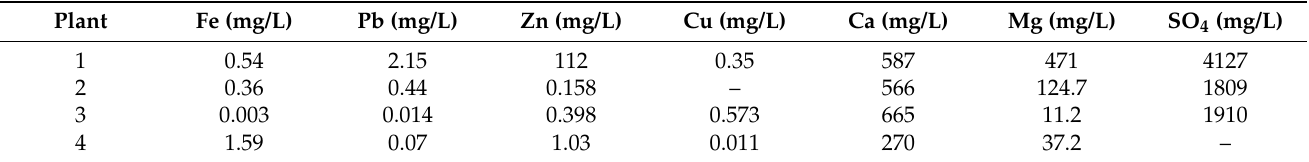
Table 1. Main metals and sulphate ions concentrations present in the process water of four lead-zinc sulfide ores flota- tion